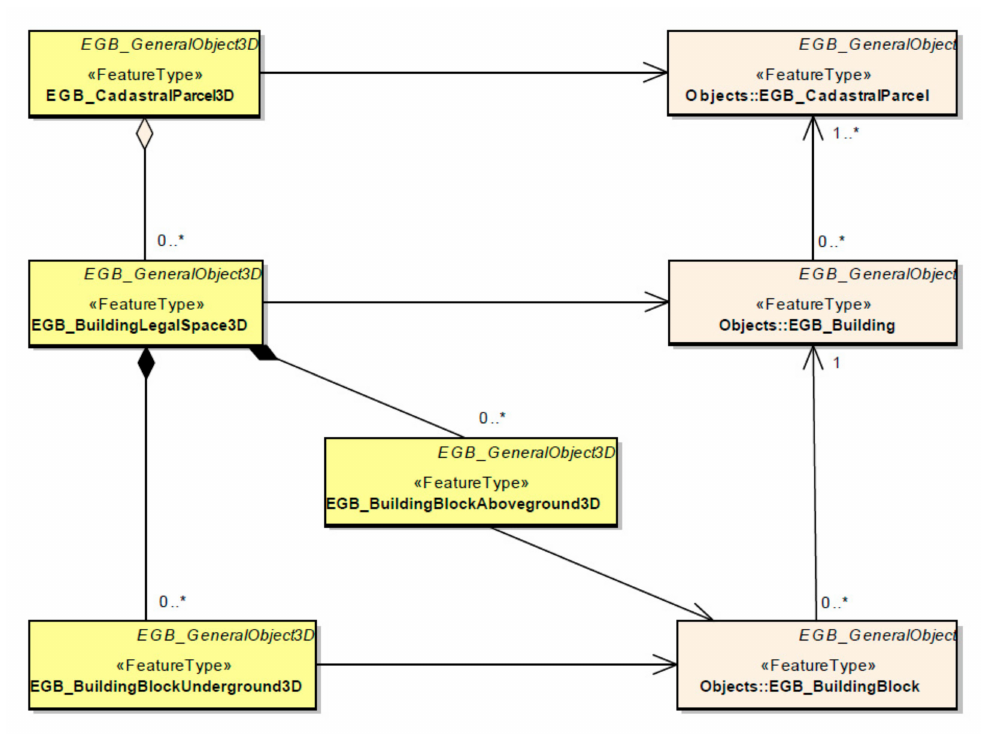
Figure 6. Diagram of ‘Parcel3DBuilding3D’ defining the relationships between ‘Cadastral Parcel’, ‘Cadastral Parcel 3D’ and both 2D and 3D building